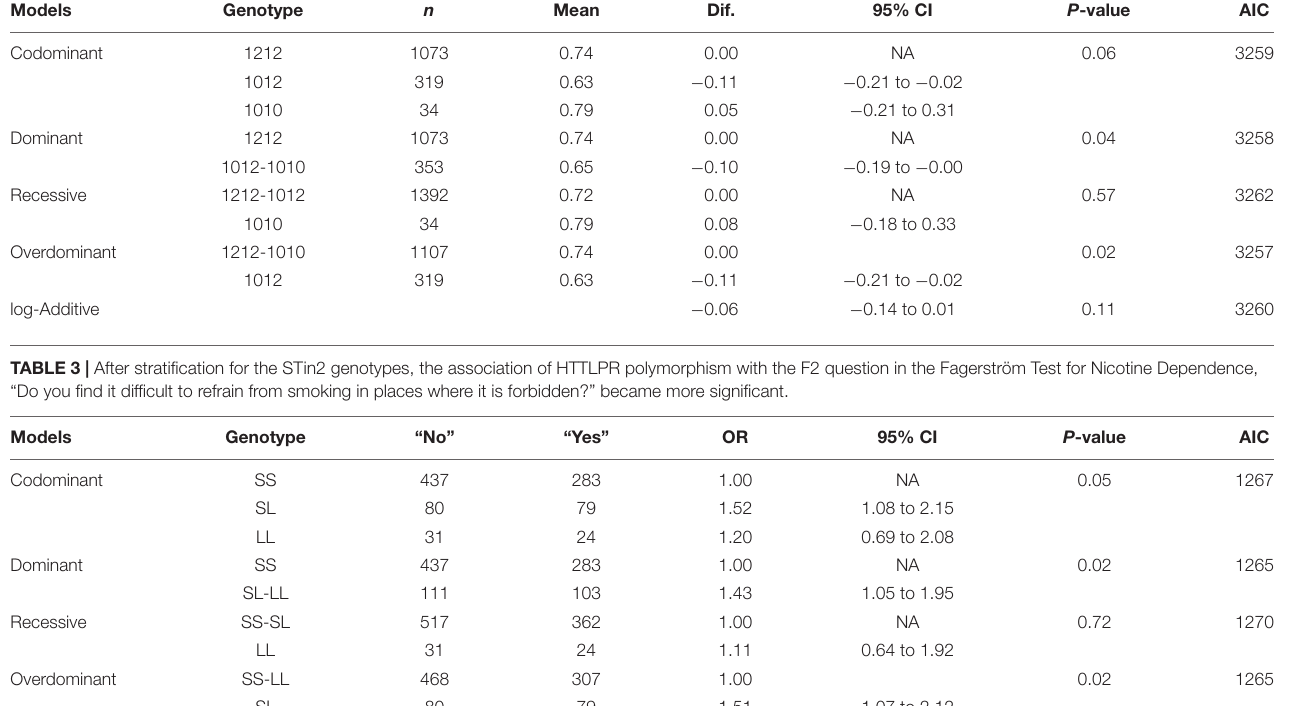
TABLE 2 | Polymorphisms in the second intron (STin2) of SLC6A4 gene are associated with the F4 question in the Fagerström Test for Nicotine Dependence, “How many cigarettes per day do you smoke?” Number of cigarettes was divided into four categories (“ < 11”, “11–20,” “21–30,” and “ > 30”) and transformed into Fagerström score points, 0, 1, 2, and 3.